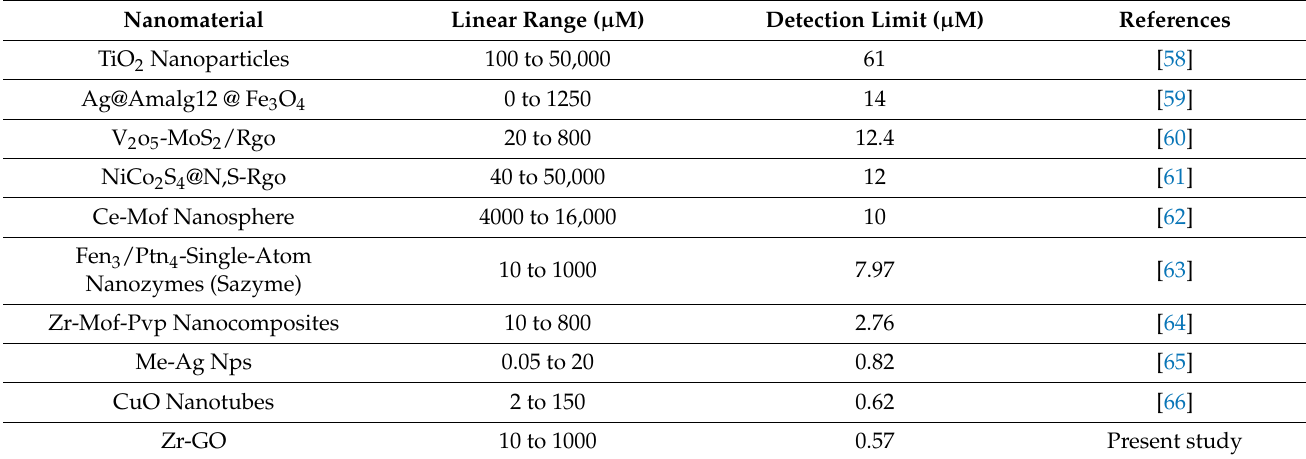
Table 3. Comparison of H 2 O 2 detection based on different assays using peroxidase mimics.